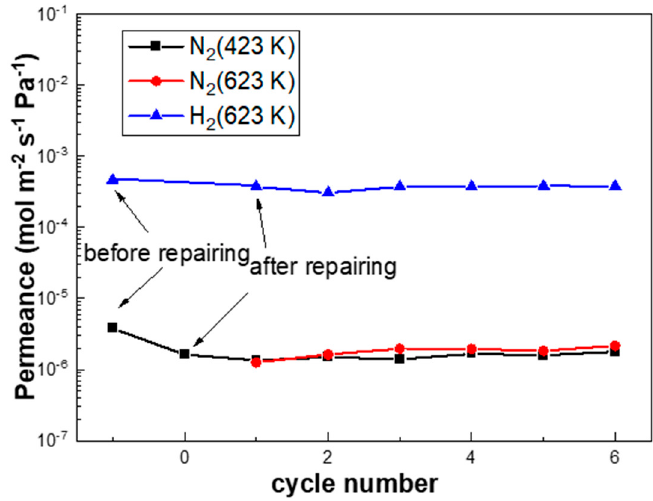
Figure 9. The performance of PA-1 after repairing during rapid heating/cooling cycles between 423 K and 623 K at a ramp rate of 10 K/min.